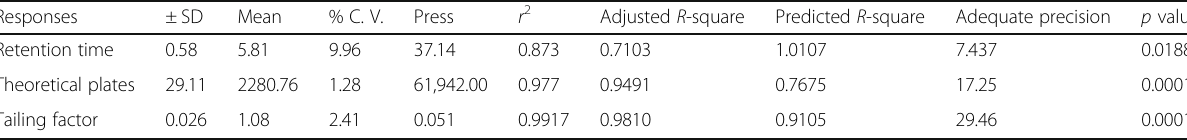
Table 2 ANOVA results